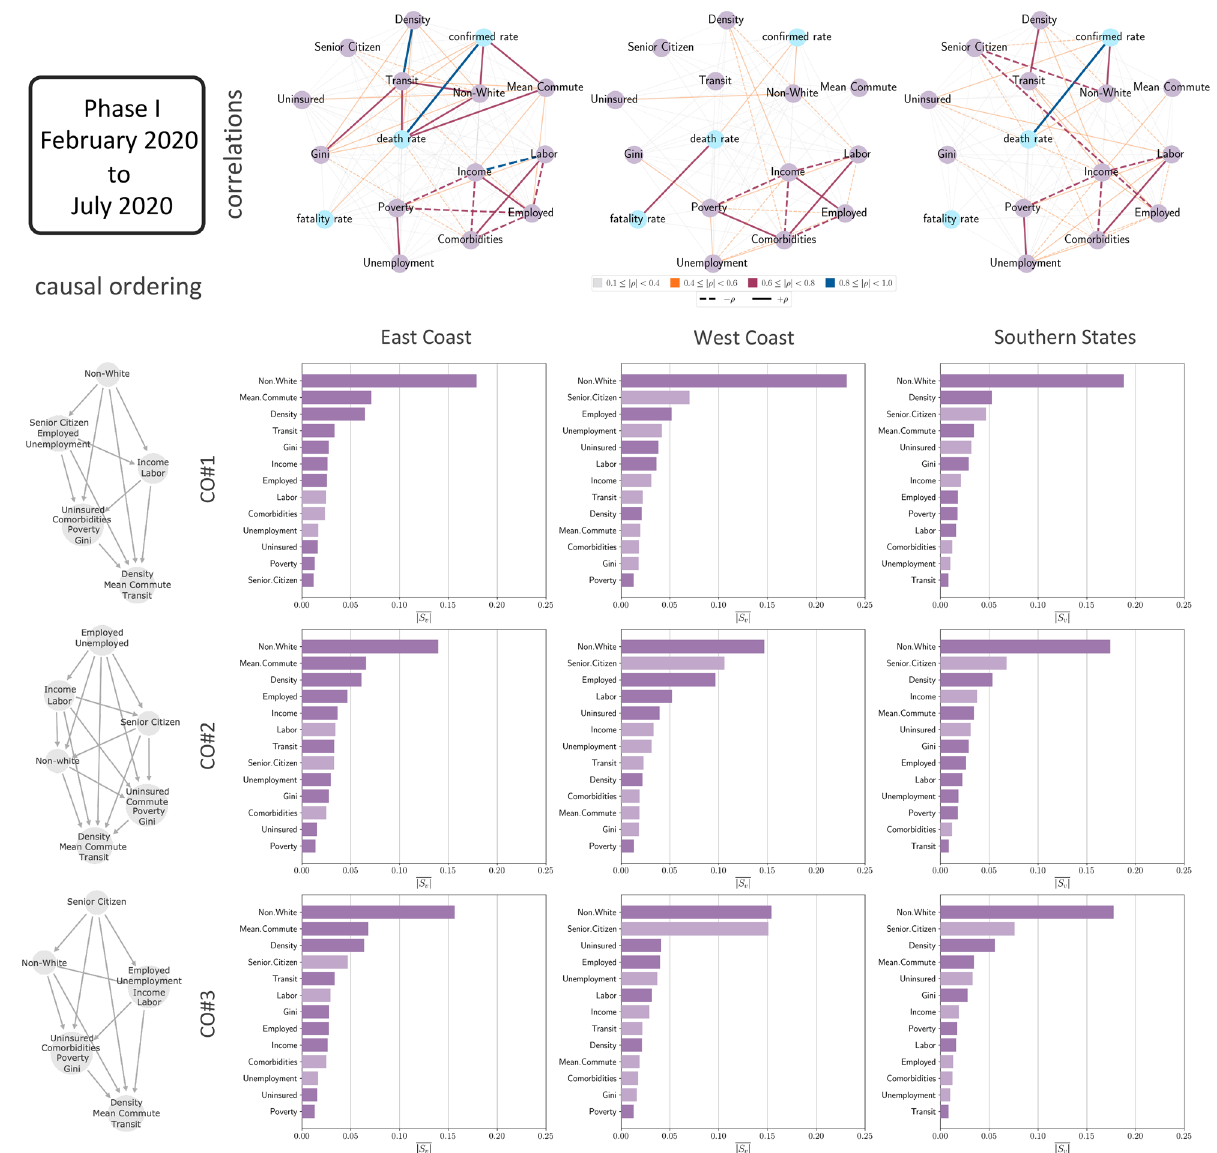
Figure 3. The causal connection between the socioeconomic metrics that we consider in this work and confirmed case rates in various regions of the USA from February 2020 to July 2020. The states included in the East Coast region are District of Columbia, New Jersey, Rhode Island, Massachusetts, Connecticut, Maryland, Delaware and New York. The ones in the West Coast region are California, Oregon and Washington. The states in the Southern States region are Alabama, Arkansas, Florida, Georgia, Kentucky, Louisiana, Mississippi, North Carolina, Oklahoma, South Carolina, Tennessee, Texas, Virginia and West Virginia. The networks in the top row show the correlations between the different metrics in the three regions. The graphs in the left column of the plot show the three partial causal orderings that we consider in this analysis. Each panel of the array of bar plots show the hierarchy of the metrics in terms of mean absolute causal SHAP values, | S v | , for a particular region and causal ordering. The lighter shaded bars indicate a negative effect of the metric on the confirmed case rates while the darker bars indicate a positive